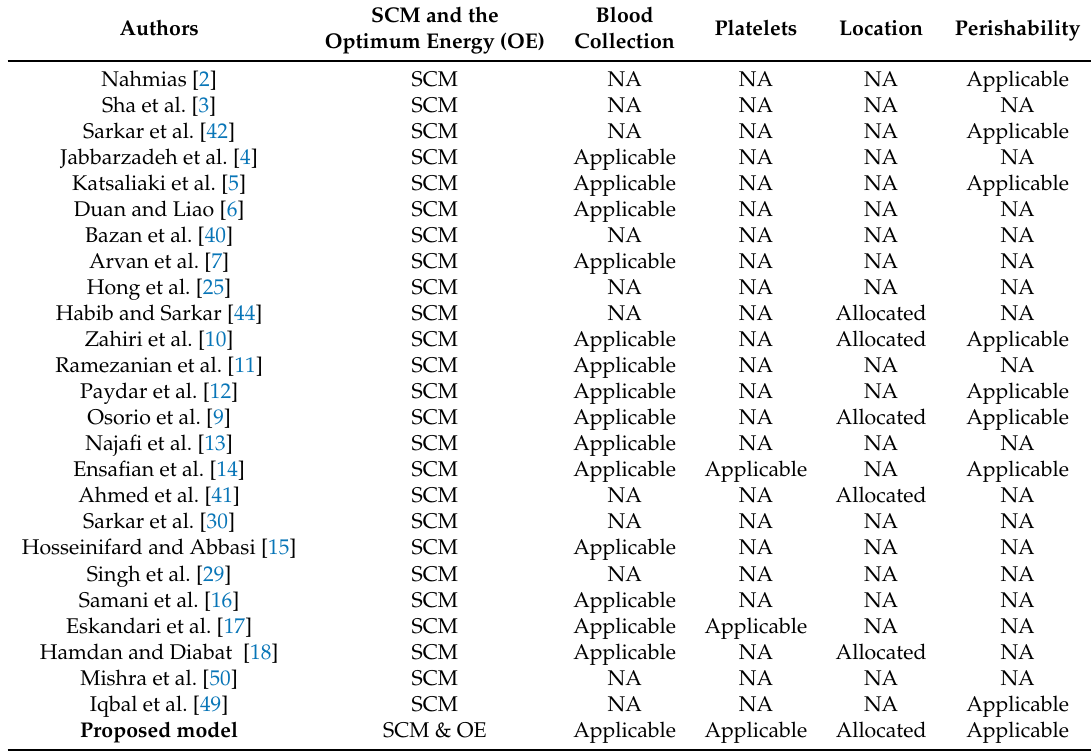
Table 1. Contributions of different